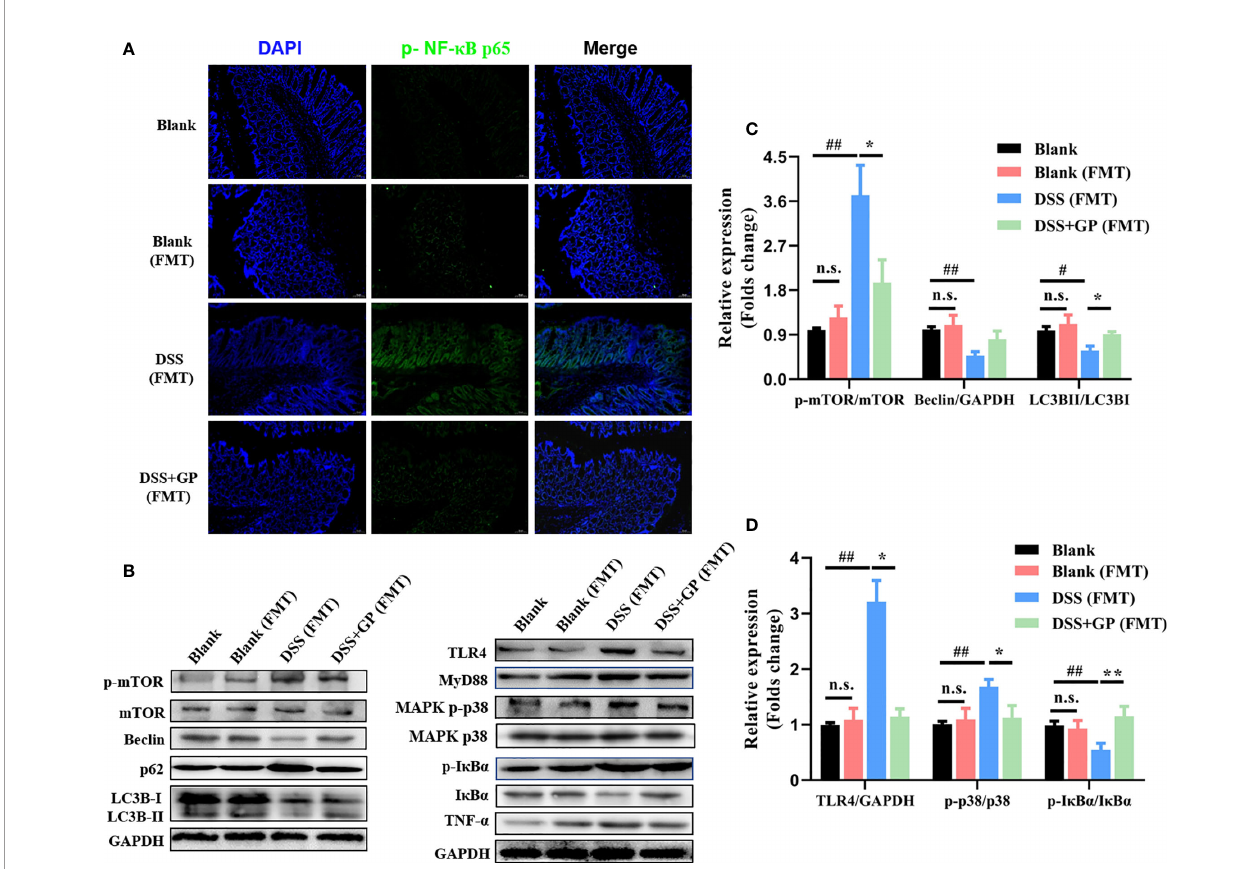
FIGURE 7 | Transplanting of fecal microbiome intervened by GP improves intestinal in fl ammation. (A) Immuno fl uorescence for p-NF- k B was performed on colon sections. (B) The expression of autophagy-related and in fl ammation-related proteins measured by western blot. (C, D) The expressions of proteins were quanti fi ed by the ratio of phosphorylated protein/total protein and total amount protein/GAPDH. All data shown are representative of 3 independent experiments. Bars in graphs represent mean ± SD, # P < 0.05, ## P < 0.01 VS Control group; *P < 0.05, **P < 0.01 VS DSS group, n.s., no signi fi cant